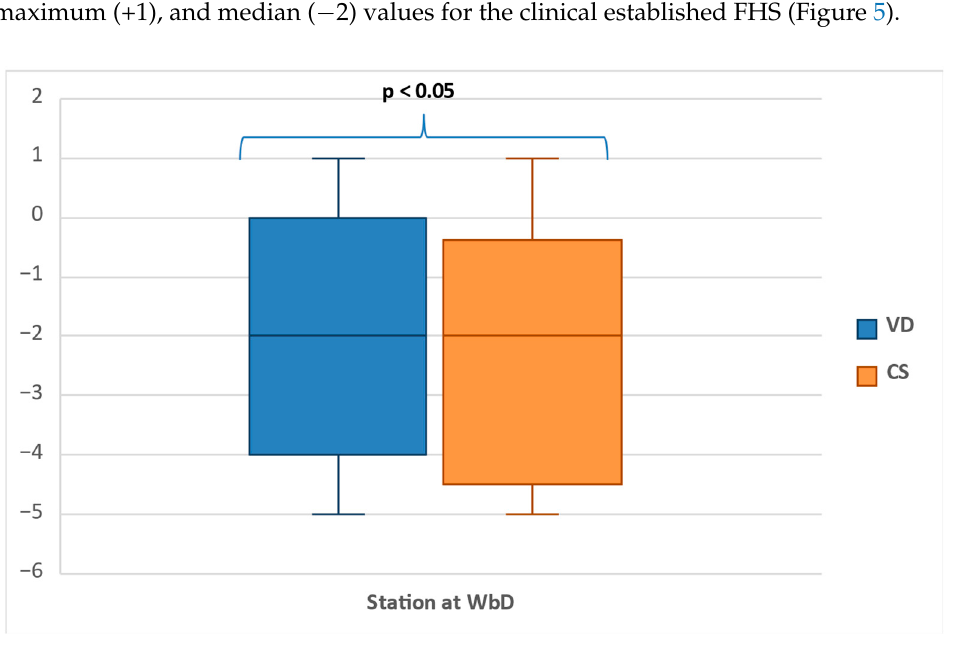
Figure 6. The comparative distribution of the clinical fetal head station in the week before delivery between the vaginal delivery group and the Caesarean section delivery group. VD, vaginal delivery; CS Caesarean section delivery.